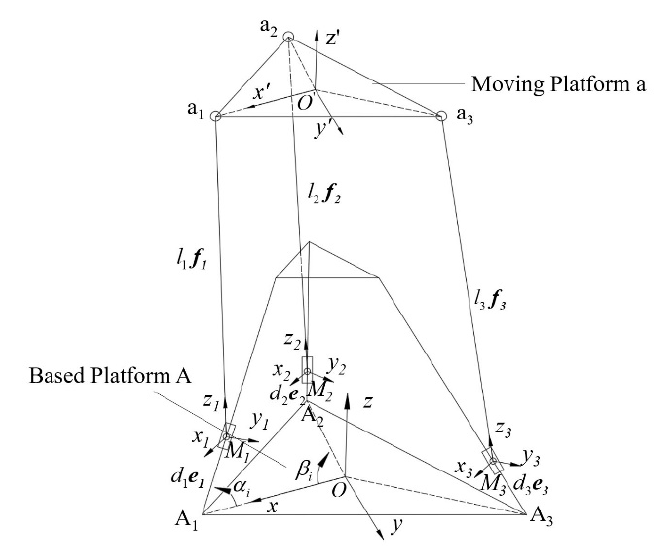
Figure 8. Schematic diagram of 3PUU moving part. Through the analysis of the degree of freedom, it is found that the 3PUU moving part only has three translational degrees of freedom, which induces φ = θ = ψ = 0. Thus, the T of the moving platform relative to the based platform can homogeneous transfer matrix o o (cid:48) be written as